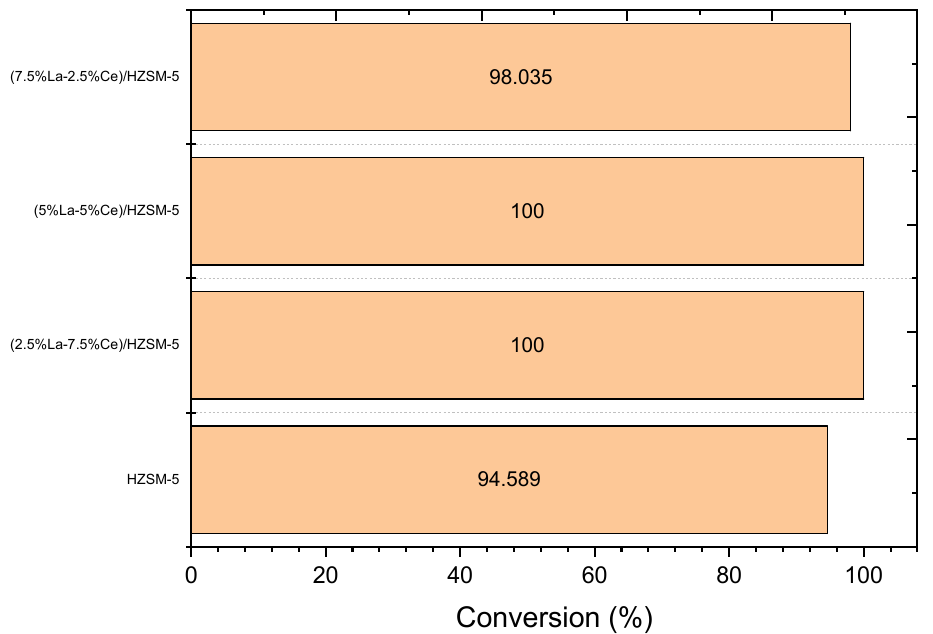
Figure 11. Conversions of the algal HO of the catalytic deoxygenation reactions for the parent HZSM-5, (2.5%La-7.5%Ce)/HZSM-5, (5%La-5%Ce)/HZSM-5, and (7.5%La-2.5%Ce)/HZSM-5 at specified operating conditions (batch reactor, 300 ◦ C, 1000 rpm, 7 bar of N 2 inert gas (initial pressure), catalyst-to-algal HO ratio = 15% (wt.%), and 6 h). Table 4. Mass balances (wt. %) of the algal HO compound in the feed and the compounds of liquid products for the conversion of HO for HZSM-5, (2.5%La-7.5%Ce)/HZSM-5, (5%La-5%Ce)/HZSM-5, and (7.5%La-2.5%Ce)/HZSM-5. Content (wt.%) of the Compound in the Liquid Product of the Catalytic Deoxygenation Reactions for the Algal HO as a Function of